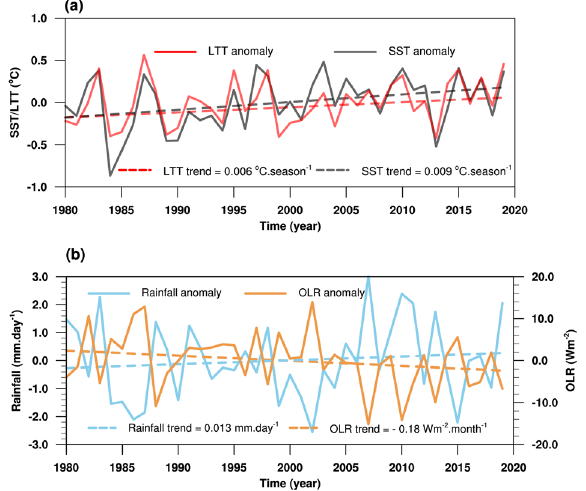
Fig. 1 Interannual variability of LTT, SST, rainfall and OLR. a Interannual variability of anomalous sea surface tem- perature (SST) (°C, black) and lower tropospheric temperature (LTT: 1000 hPa to 700 hPa average) (°C, red) anomalies respectively over the Arabian sea (65 – 70 °E and 15 – 20 °N) and the western coast of India (73 – 77 °E and 8 – 20 °N) during JJAS. b Interannual variability of anomalous rainfall (mm.day − 1 , Blue) and OLR(Wm − 2 , Orange) anomalies, respectively, over the western coast of India (73 – 77 °E and 8 – 20 ° N) during JJAS. Fitted trends obtained by linear regression on year are indicated by dashed lines.